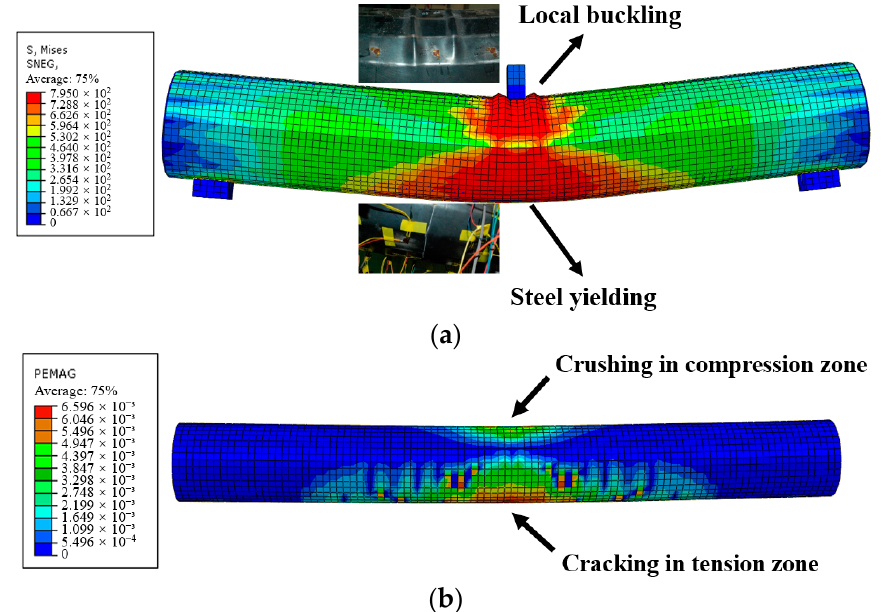
Figure 10. ( a ) CFHST member; ( b ) Core concrete.